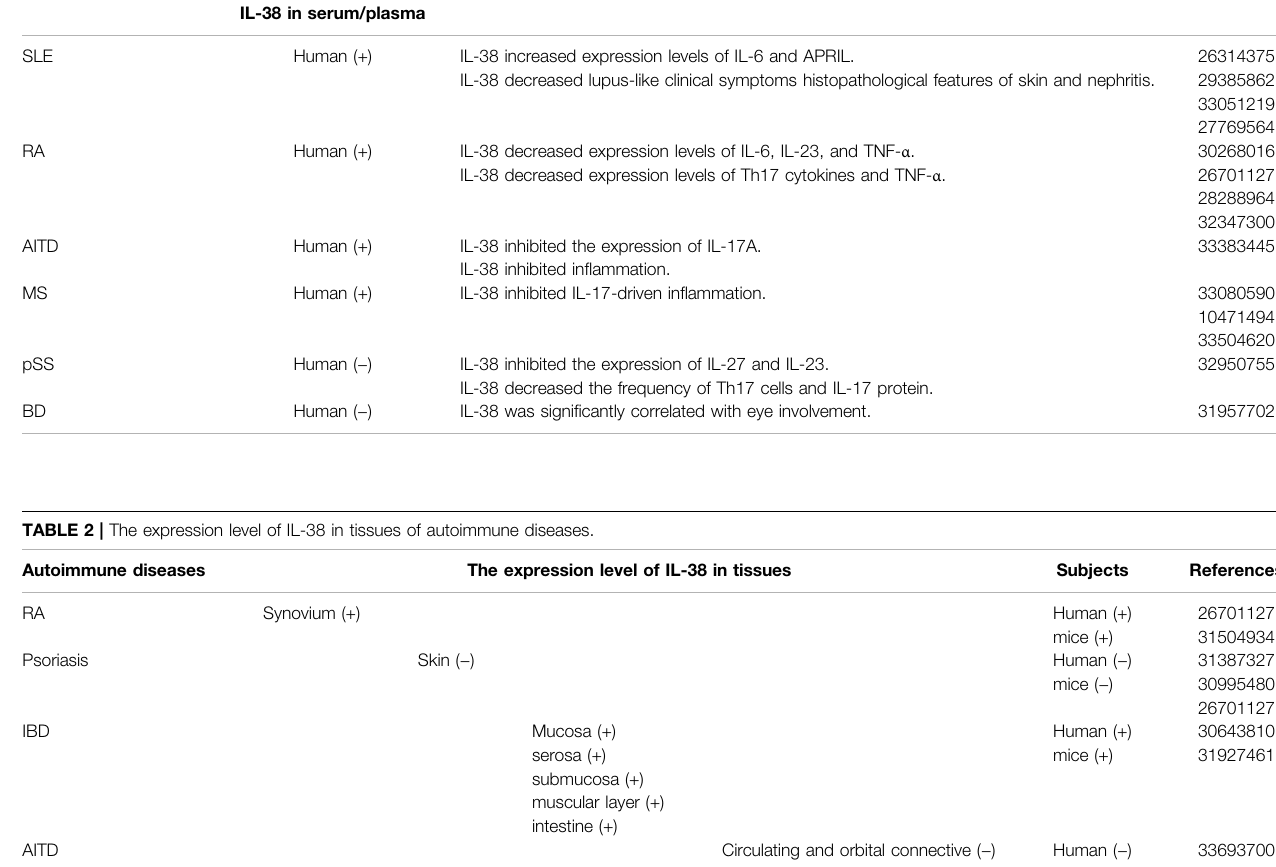
TABLE 1 | The expression and function role of IL-38 in autoimmune diseases. Autoimmune diseases Expression level of IL-38 in serum/plasma